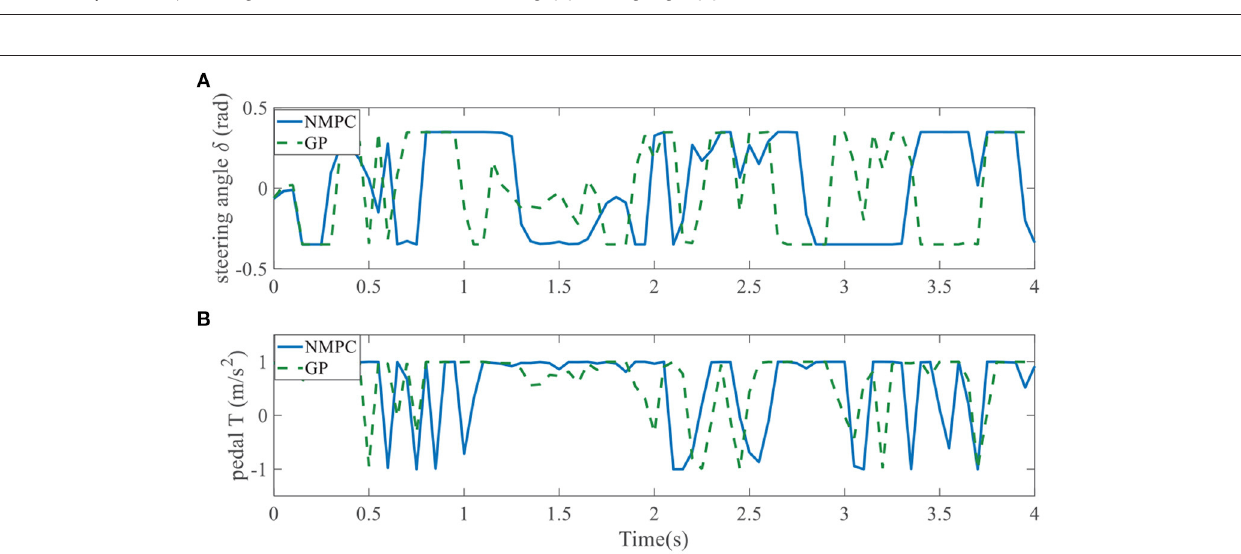
FIGURE 19 | Control inputs using NMPC and GPMPC for left overtaking. (A) Steering angle; (B) Pedal.